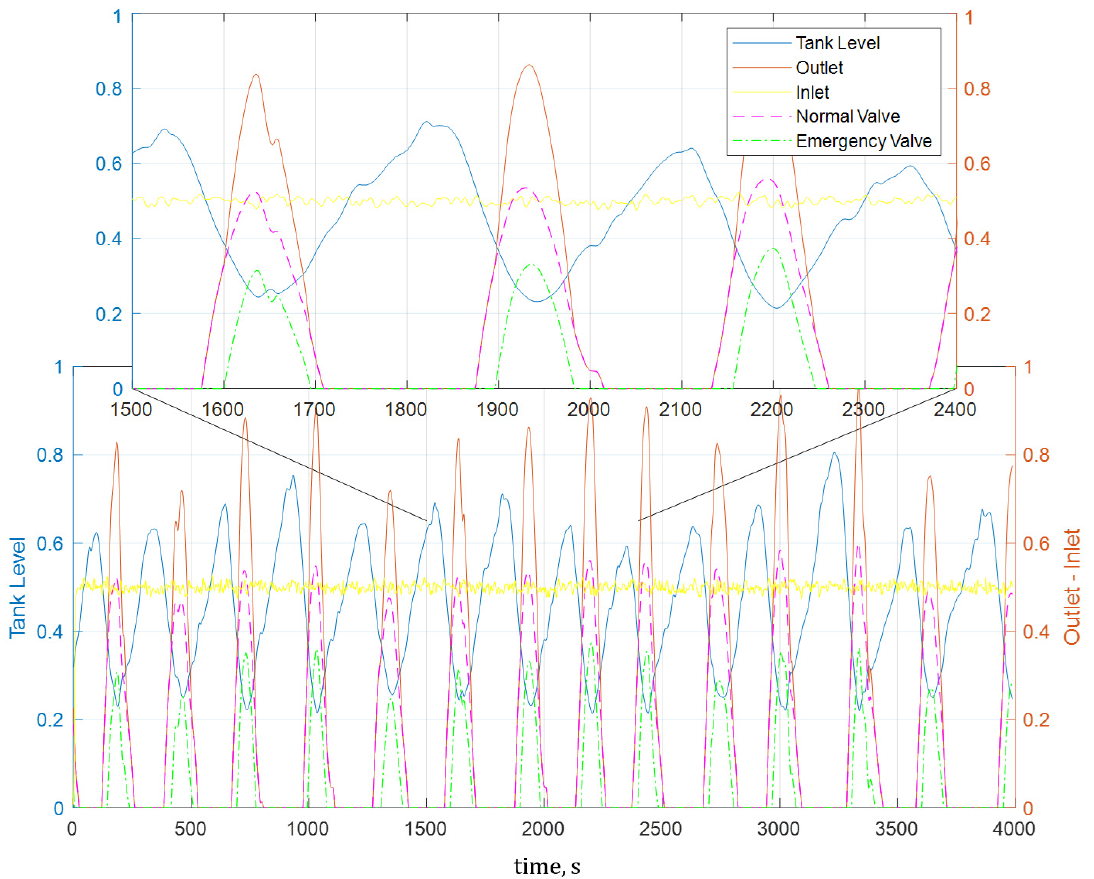
Figure 3. Gas cleaning tank system level change with changes of inlet and outlet valve.